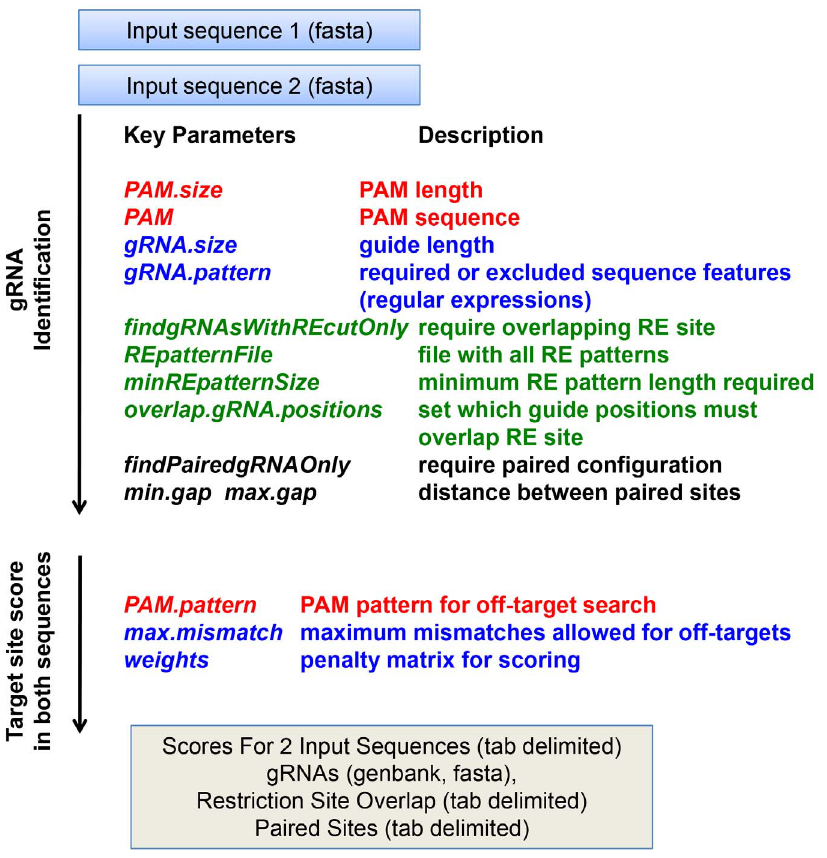
Figure 2. Major parameters to identify gRNA-Cas9 target sites that are shared or distinct in two related sequences with the compare2sequences function of CRISPRseek. compare2sequences first identifies target sites in two input sequences using many of the same parameters available for the offTargetSequence function. Next, cleavage scores are determined for each target site in both target sequences.